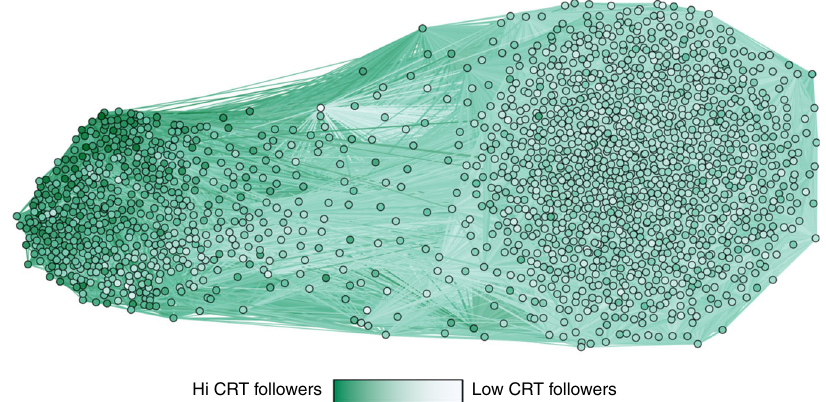
Fig. 1 Co-follower network. Nodes represent Twitter accounts followed by at least 25 users in our dataset and edges are weighted based on the number of followers in common. The intensity of color of each node shows the average CRT score of its followers (darker = higher CRT score). Nodes are positions using directed-force layout on the weighted network (edges with weight <5 are not shown for visualization purposes). Visualization depicts two distinct communities that differ in the CRT scores of their followers.